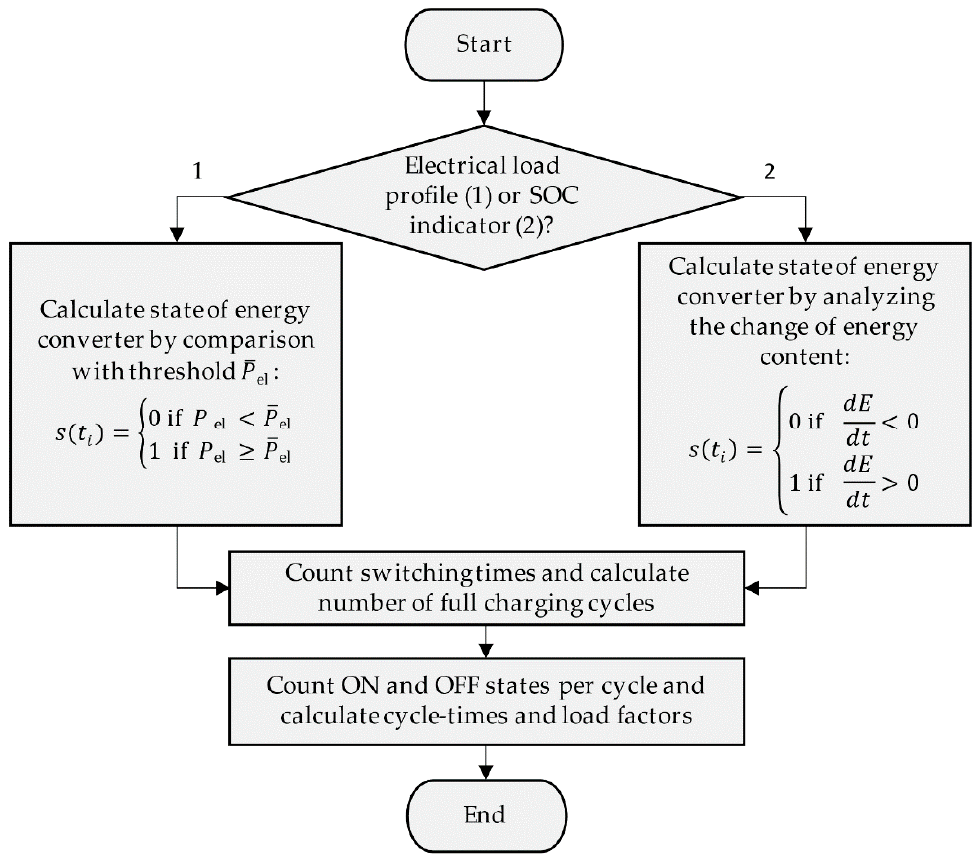
Figure 4. Program flow chart of the load analysis function for extraction of the characteristic values from measured data of the electrical power of the energy converter or the SOC indicator.